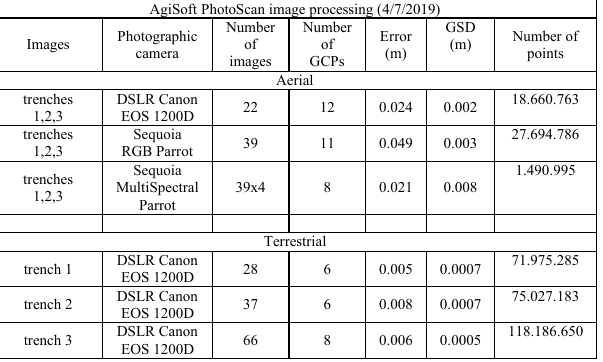
Table 3 . Number of images, GCPs and Error (m) during the Agisoft Photoscan image processing (4/7/2019).